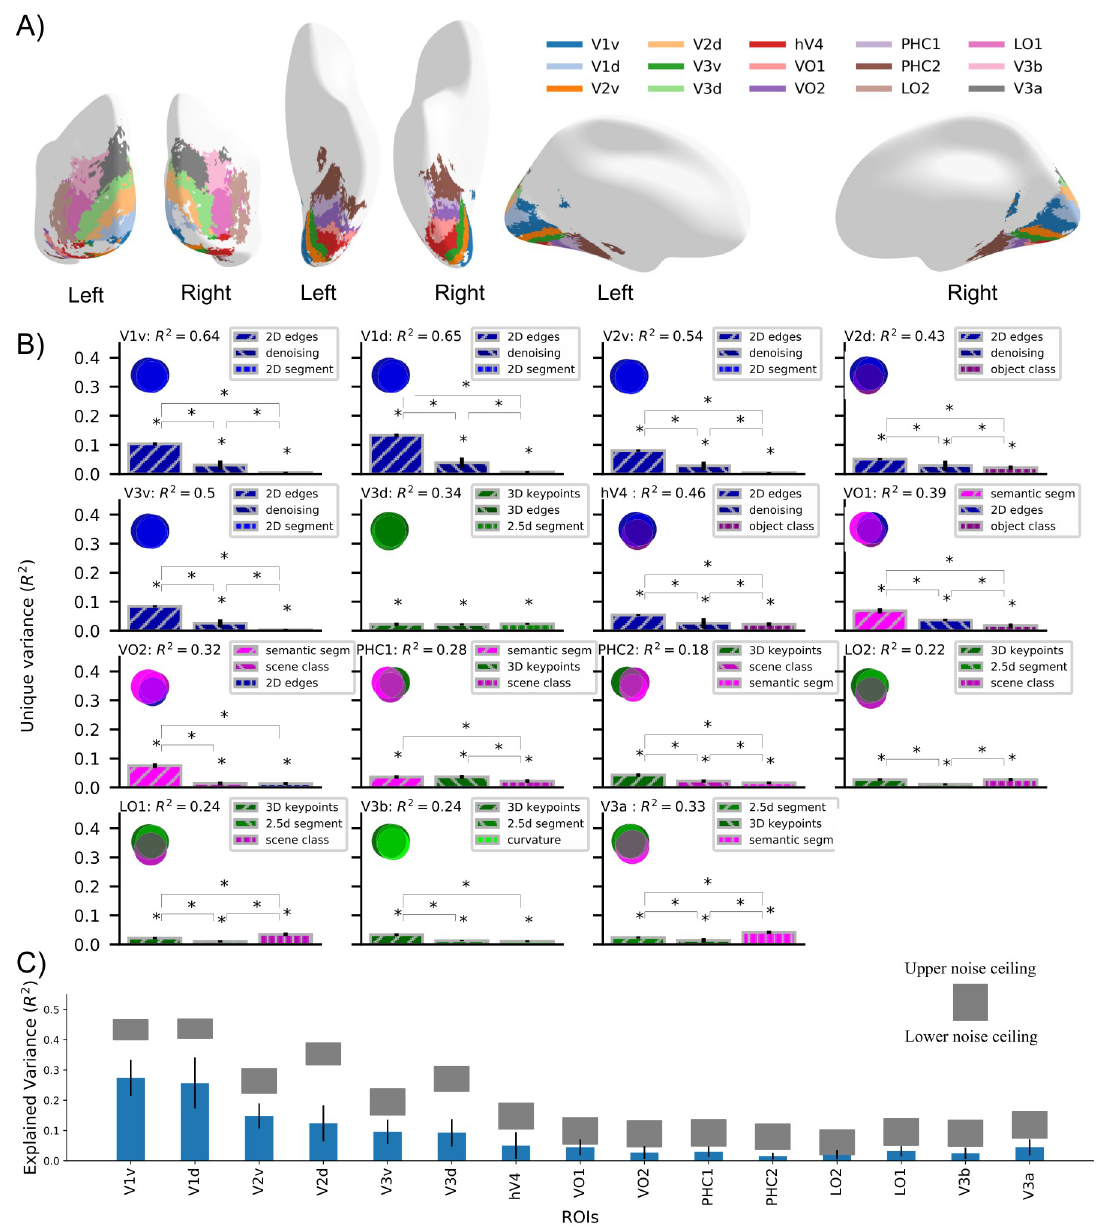
Fig 2. Nature and predictive power of the functional map. A) Cortical overlay showing locations of selected cortical regions from the probabilistic atlas used. B) Absolute total variance (R 2 ) explained in 15 ROIs by using the top-3 DNNs together. The Venn diagram for each ROI illustrates the unique and shared variance of the ROI responses explained by the combination of the top-3 DNNs. The bar plot shows the unique variance of each ROI explained by each of the top-3 DNNs individually. The asterisk denotes the significance of unique variance and the difference in unique variance (p < 0.05, permutation test with 10,000 iterations, FDR-corrected across DNNs). The error bars show the standard deviation calculated by bootstrapping 90% of the conditions (10,000 iterations). C) Variance of each ROI explained by top-3 best predicting DNNs (cross validated across subjects and conditions) indicated in blue bars compared with lower and upper bound of noise ceiling indicated by shaded gray region. The error bars show the 95% confidence interval calculated across N = 16 subjects. All the R 2 values are statistically significant (p < 0.05, two-sided t-test, FDR-corrected across